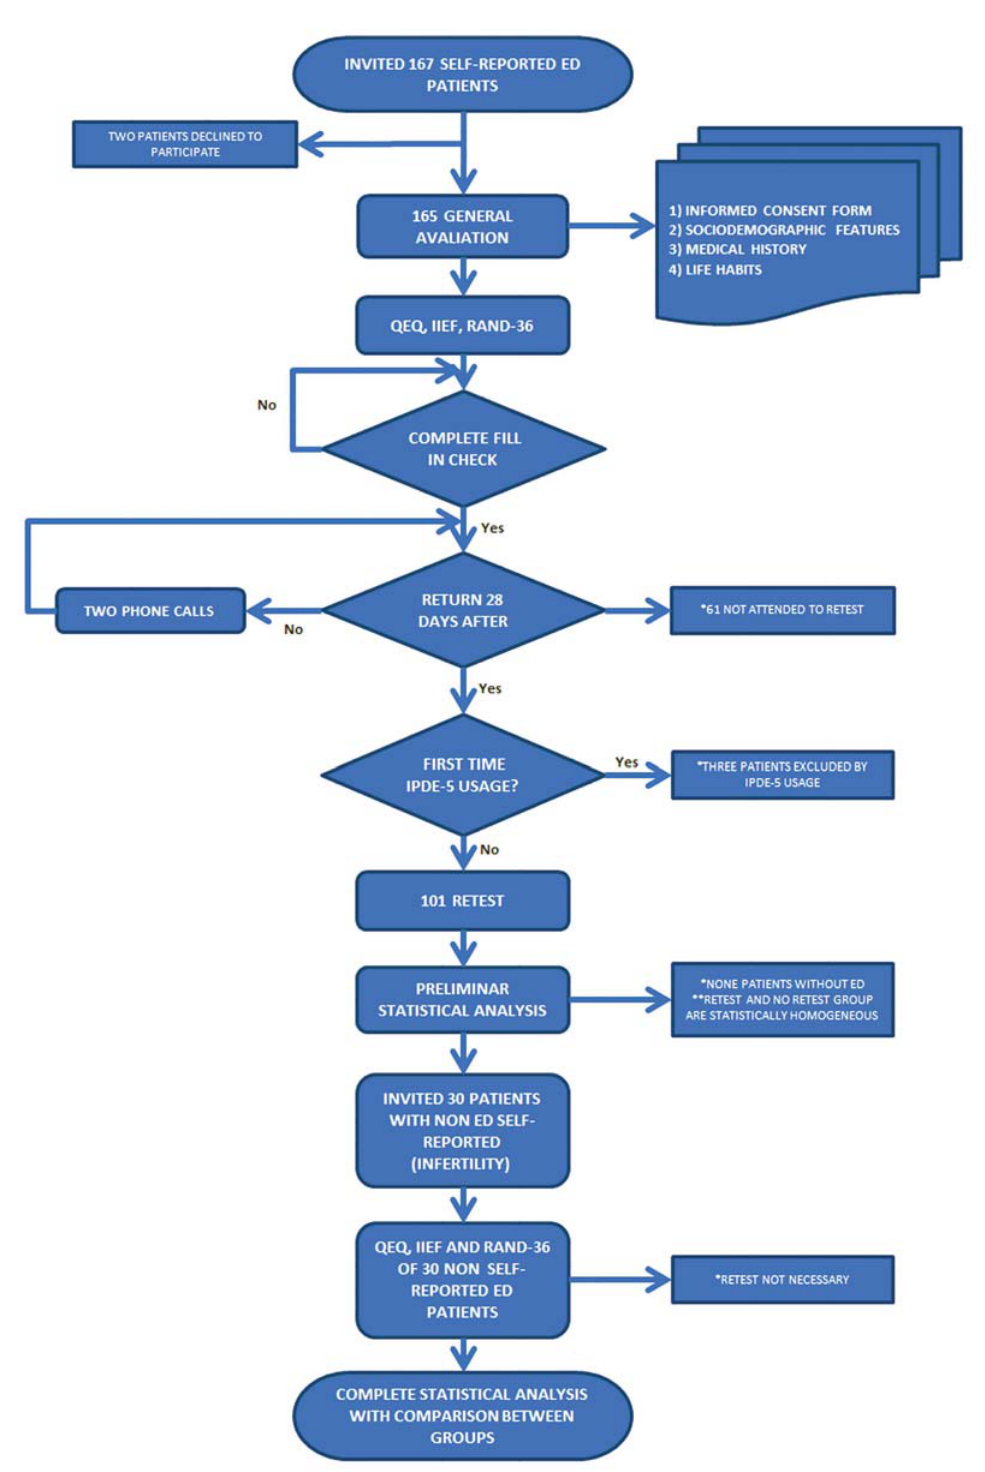
Figure 2 - Study flow